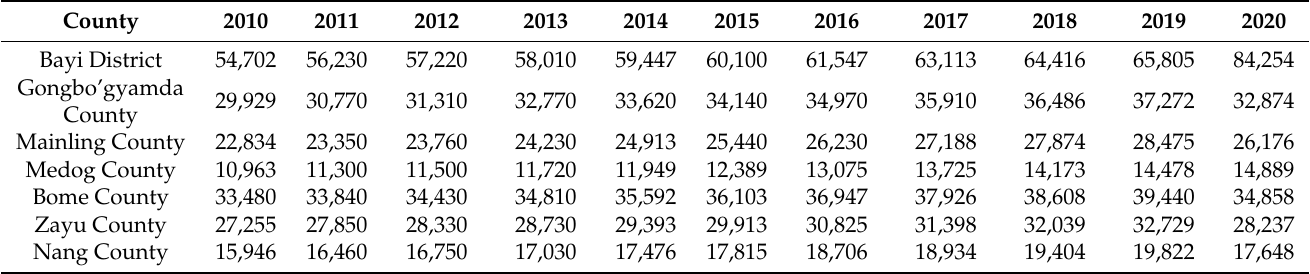
Table 3. The administrative division data of Nyingchi (unit: number). Country